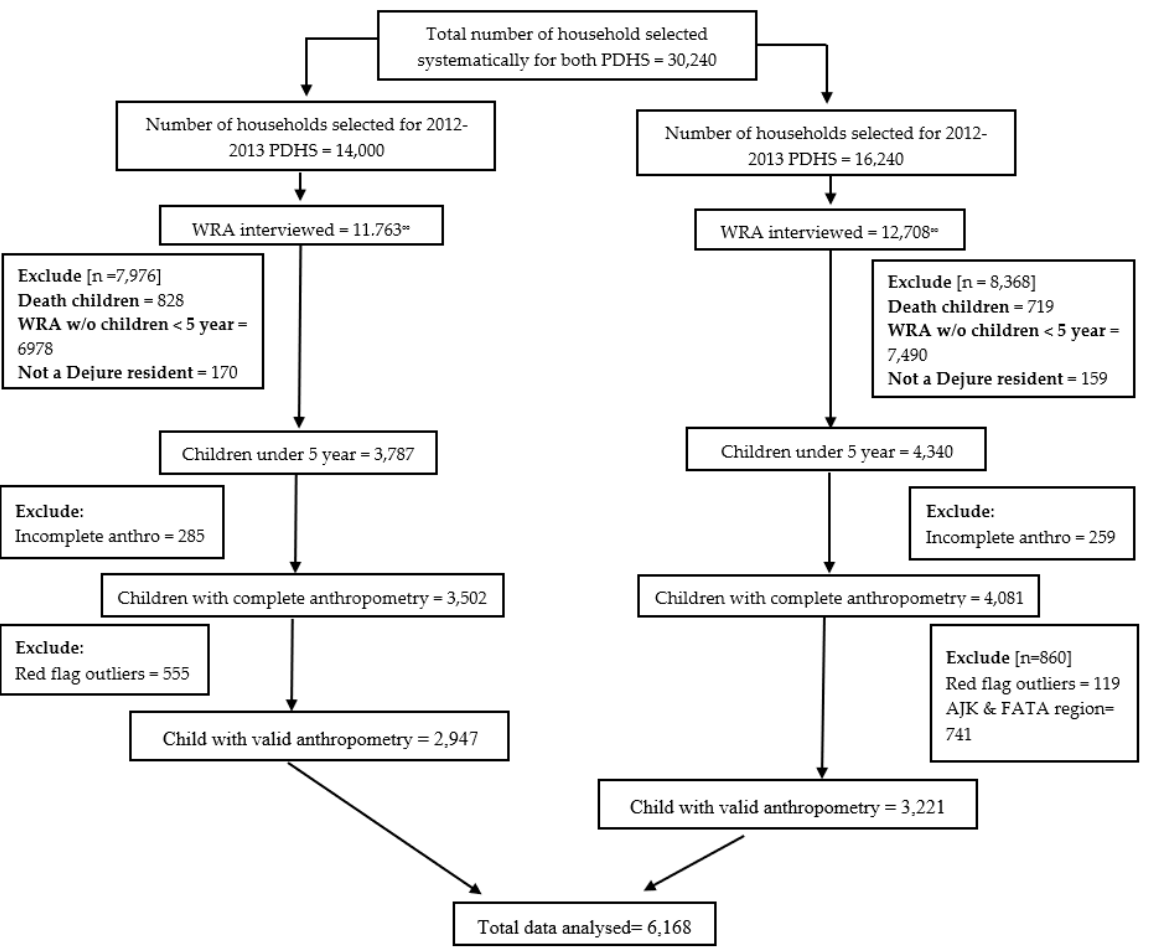
Figure 1. Child nutritional status assessment based on z-score and anthropometric indices. PDHS = Pakistan Demographic and Health Survey; WRA = Women of Reproductive Age; w/o = Without; Incomplete Anthro. = The dataset has missing information about the child age or sex, or weight, or length/height, or measurement method (standing/recumbent); ∞ = Number of WRA were less than the calculated sample size because of refusal and/or ineligibility and/or inaccessibility due to geopolitical/security issues; Red flag outliers = The z-scores calculated for HAZ/LAZ exceeds over ± 6.00 S.D., WHZ exceeds over ± 5.00 S.D., and of WAZ must exceed − 6.00 and +5.00 S.D.,